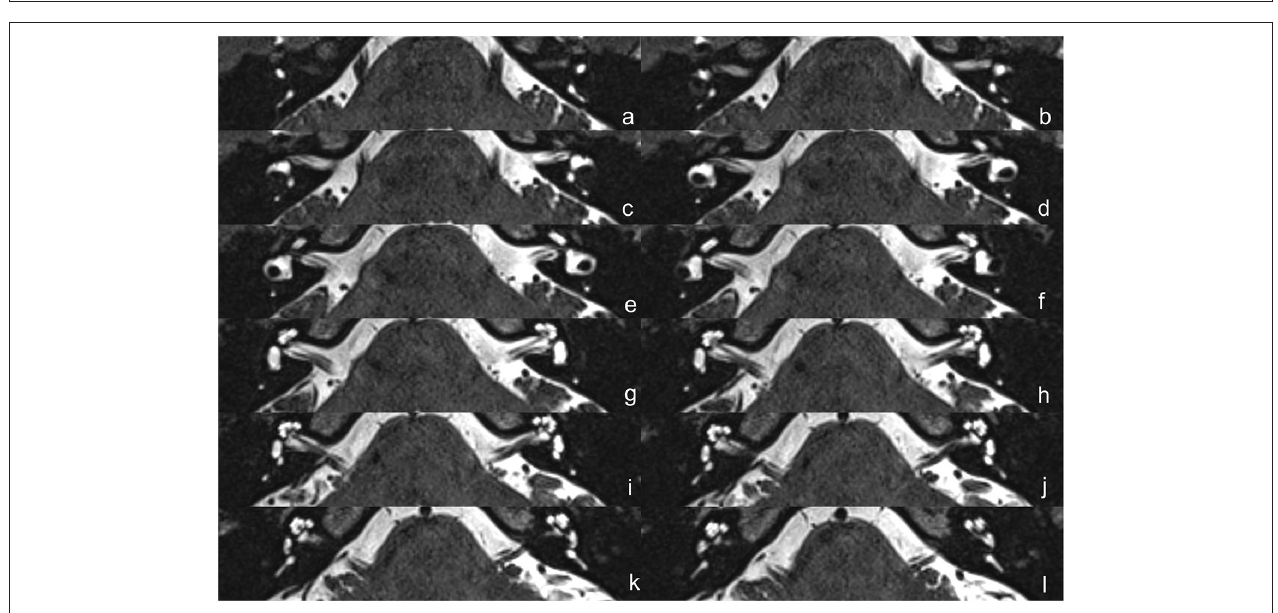
FIGURE 2 | The 3D-SPACE MRI images of a 57-year-old female with vestibular migraine (VM). (a–j) Axial, high-resolution, and T2-weighted MRI scan showing visualization of the vestibular aqueduct on both sides. 3D-SPACE, three-dimensional sampling perfection with application optimized contrasts using different flip angle evolutions, VM, vestibular migraine.